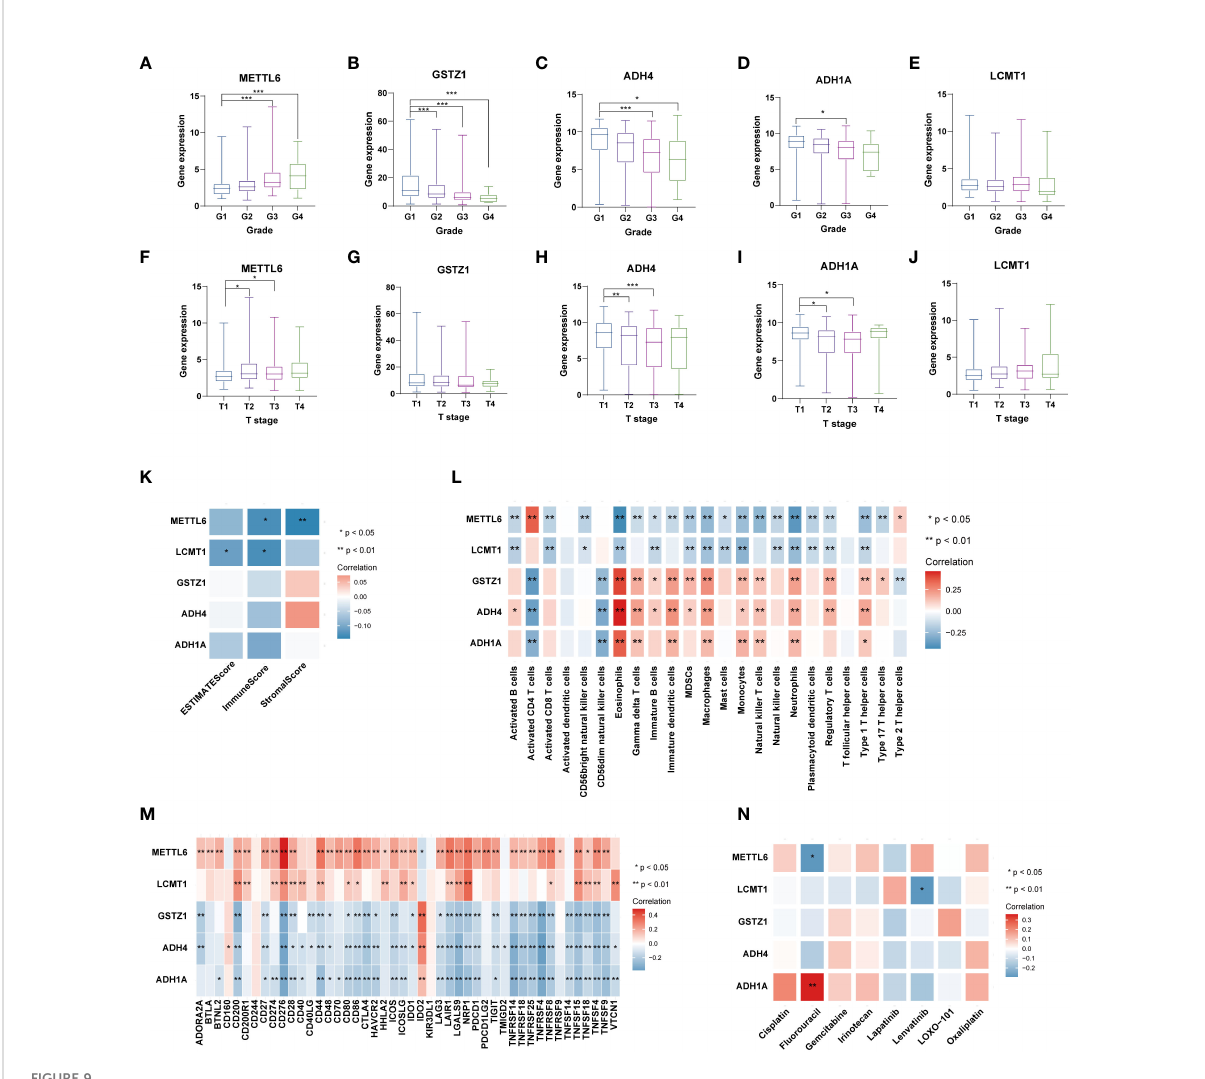
FIGURE 9 Analysis of fi ve TRGs for the prognostic signature, and their correlations of tumor immune in fi ltrating cells and therapeutic drugs. The boxplot showing the relationship of METTL6 (A) , GSTZ1 (B) , ADH4 (C) , ADH1A (D) , and LCMT1 (E) expression and grade strati fi cation. The boxplot depicting the correlation of METTL6 (F) , GSTZ1 (G) , ADH4 (H) , ADH1A (I) , and LCMT1 (J) expression and T stage. (K) The correlation of fi ve TRGs and TME score. (L) The relationship between fi ve TRGs and 23 activated immune cells. (M) The correlation of fi ve TRGs and immune checkpoints. (N) The relationship between fi ve TRGs and common therapeutic drugs for HCC. *p<0.05, **p< 0.01, ***p < 0.001. TRGs, tyrosine metabolism-related genes; TME, tumor